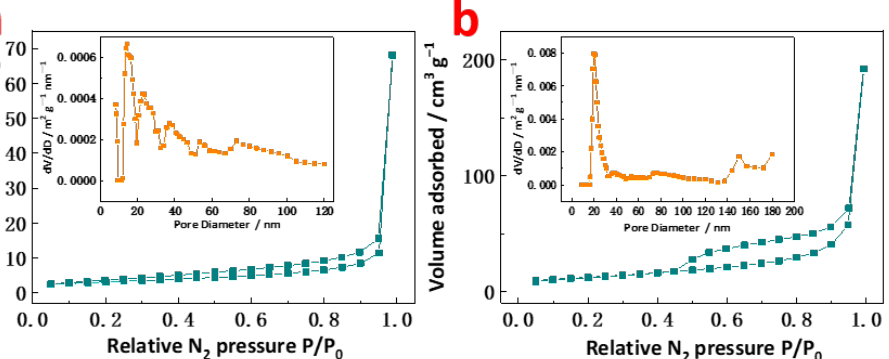
Figure 4. N 2 isotherms and corresponding pore size distribution of ( a ) dense and ( b ) hollow CoSn(OH) 6 nanocubes.